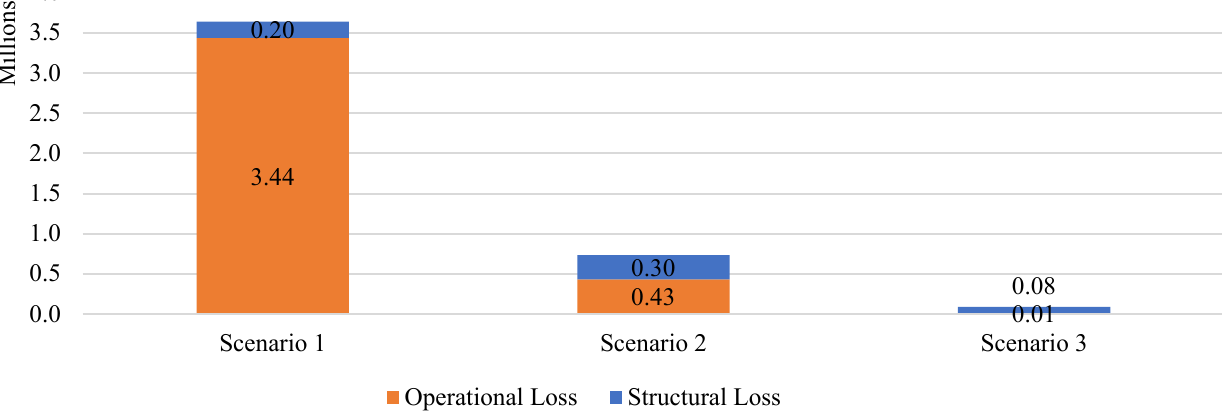
Figure 16. Total benefit/cost ratio for all three scenarios.